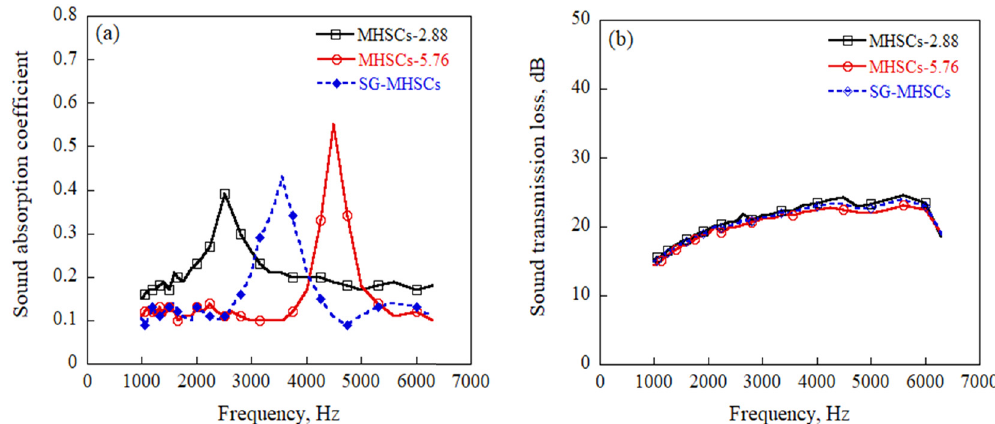
Figure 6: The acoustic properties of MHSCs: ( a ) sound absorption coe ffi cient and ( b ) sound transmission